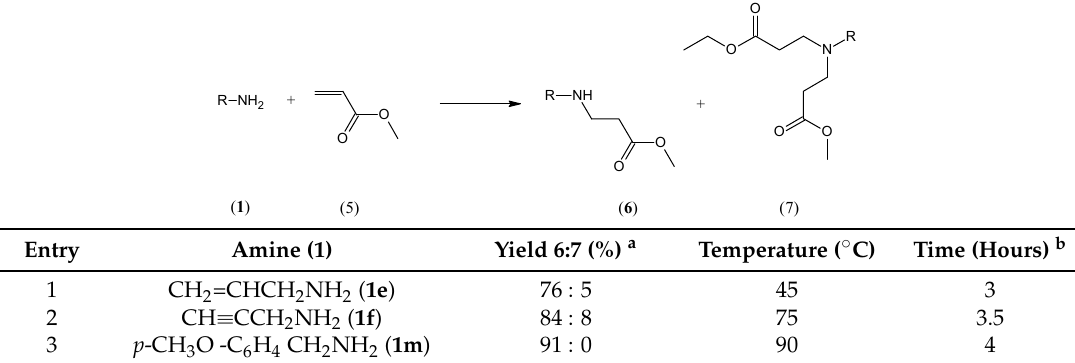
Table 3. Yields and conditions for mono-addition of various amines with different Michael